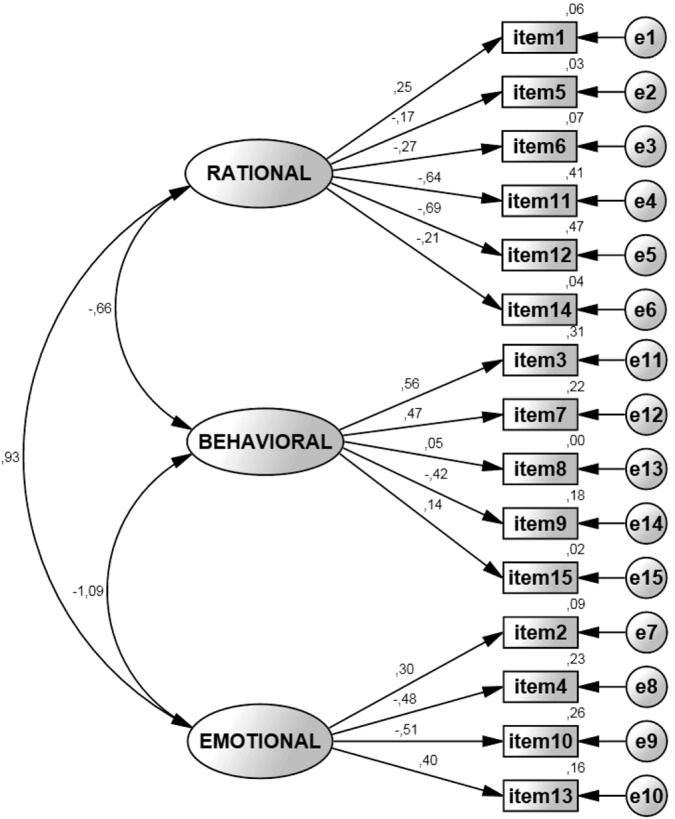
ORTO-15 as originally hypothesized by Donini and colleagues (3-factor structure).The displayed values are unstandardized regression weights from the study sample in the original 3-factor structure. Squares represent items, oval circles represent factors, squares represent questionnaire items and small circles represent error terms.